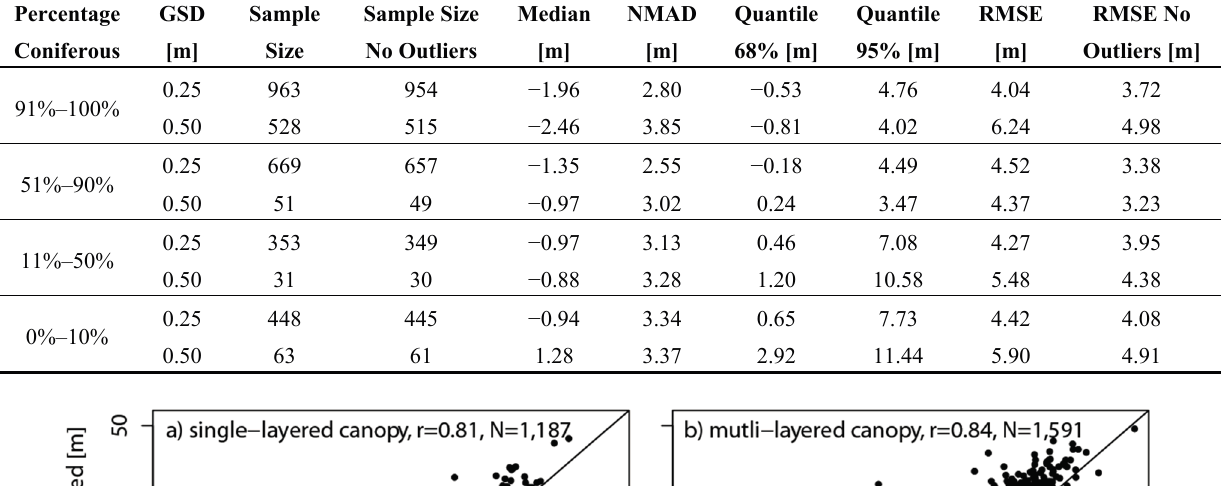
Table A6. Agreement of canopy height calculated from the CHM with the terrestrially measured canopy height according to species mixture. A threshold value of ±3 × RMSE was applied for outlier exclusion.